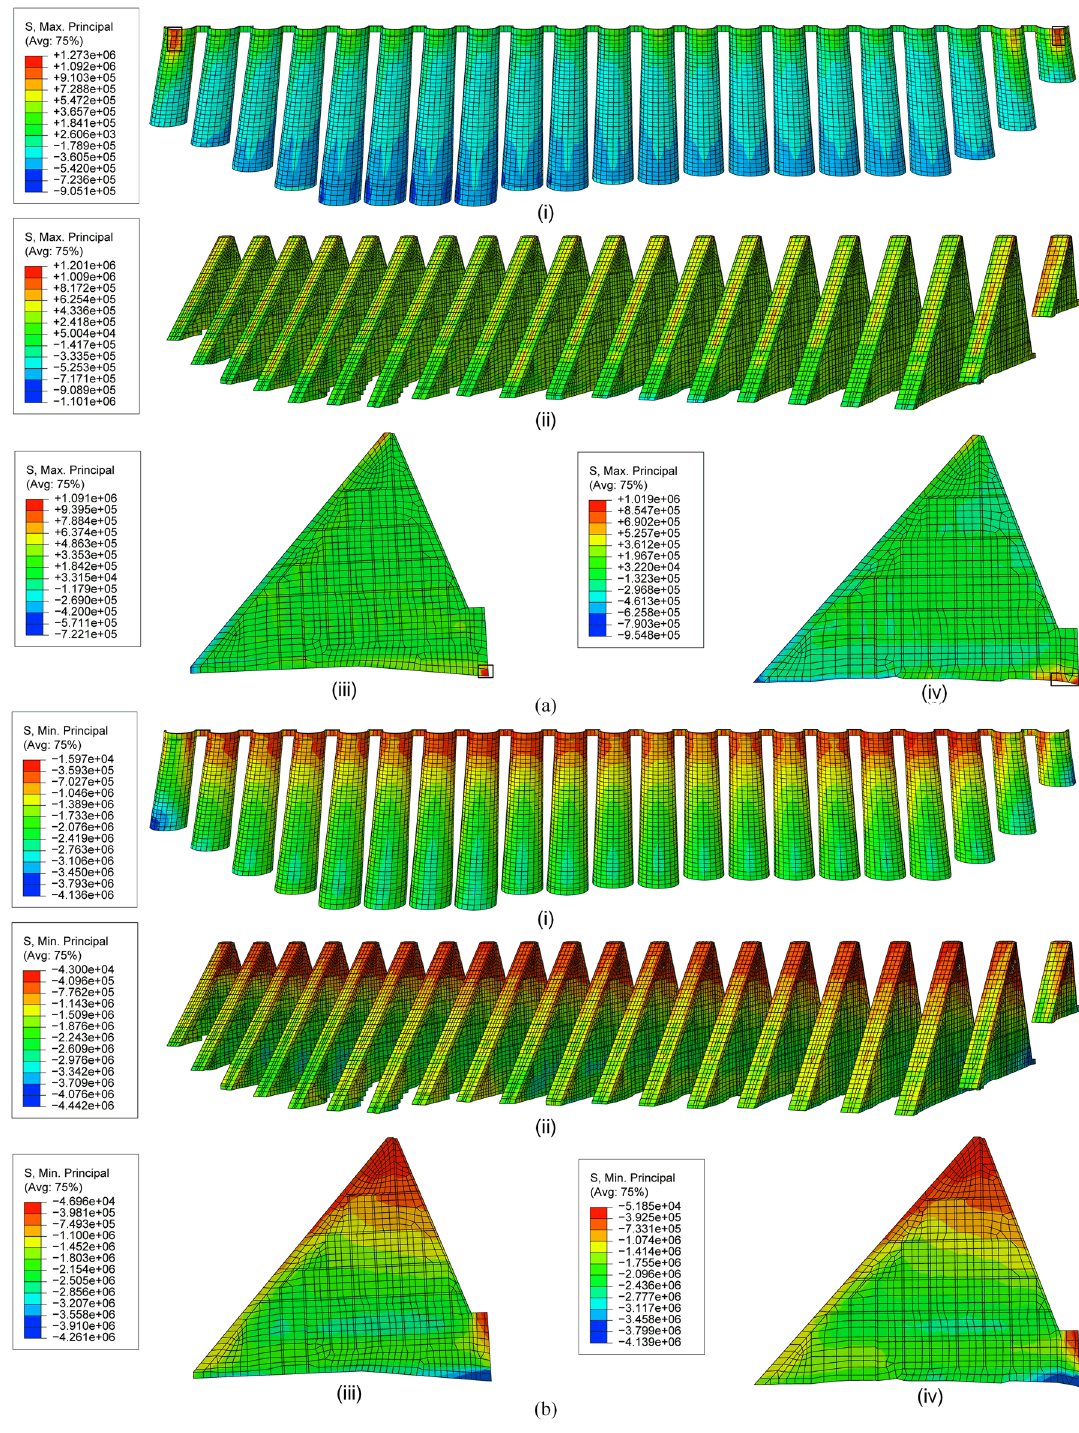
Figure 21. Principal stresses under loading C2: ( a ) maximum and ( b ) minimum principal stresses on (i) arches, (ii) buttresses, (iii) No.12 buttress and (iv) No.13 buttress (unit: